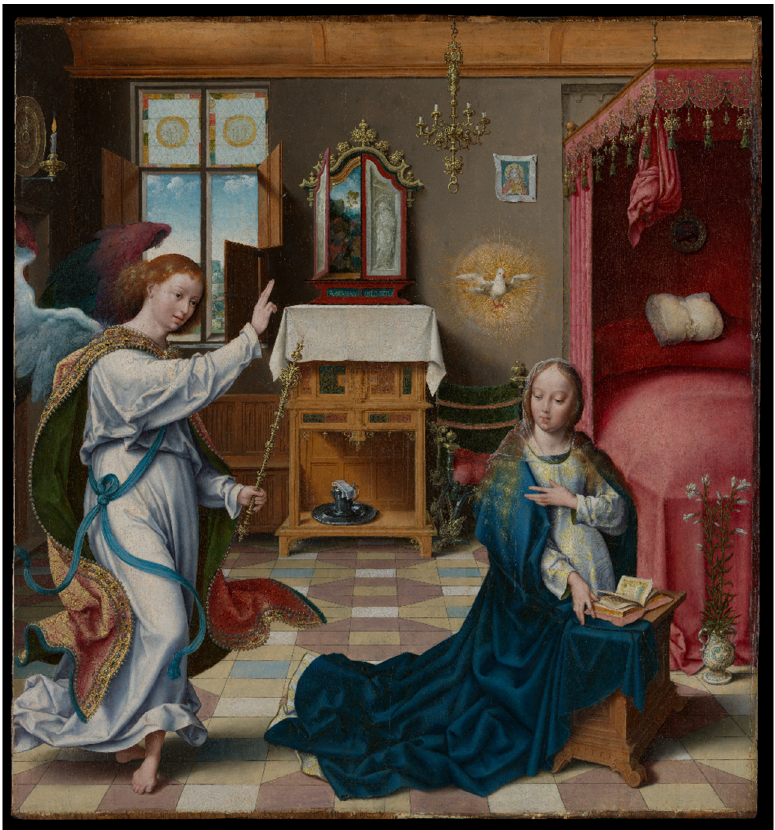
Figure 9. Joos van Cleve, Annunciation , ca. 1525. Oil on wood, 86.4 × 80 cm. New York, Metropolitan Museum of Art. © Metropolitan Museum of Art, https://images.metmuseum.org/CRDImages/ep/original/DP-19433-001.jpg (accessed on 30 October 2021). Image in the public domain.